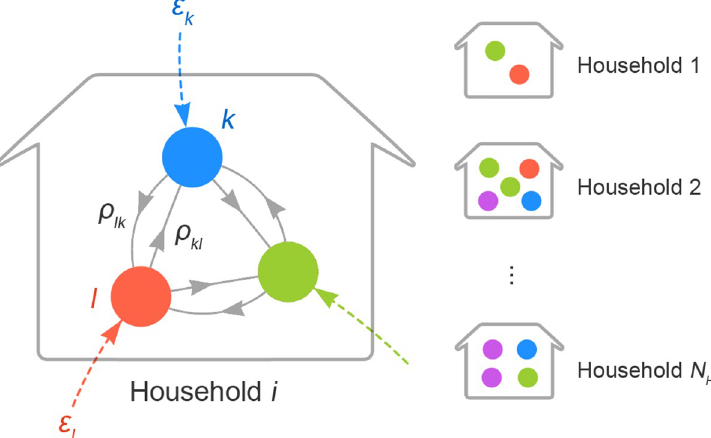
Fig 1. A schematic illustration of household chain-binomial model. Nodes in different colours correspond to different types of individuals (e.g., father, sibling, etc.). Transmission patterns are illustrated taking household i as an example. Coloured dotted edges represent the risk of external infection ε to each individual. Solid grey edges denote person-to-person transmission risk (PTR) from one type of person to another. PTR from type l to k is given as ρ which refers to the risk of transmission given that the individual of type l is infectious. Households have different compositions and ρ may also vary according to the composition. On the other hand, ε is the risk from outside the kl household and thus assumed to be identical across